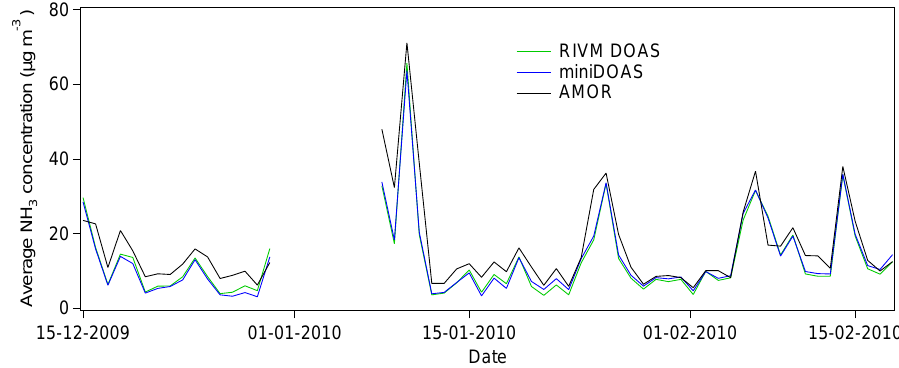
Fig. 19. Daily averaged values of RIVM DOAS, miniDOAS, and AMOR data obtained in the field in Vredepeel. data. The AMOR seems to have difficulties to reach high peaks, and, in particular, it has problems to reach very low